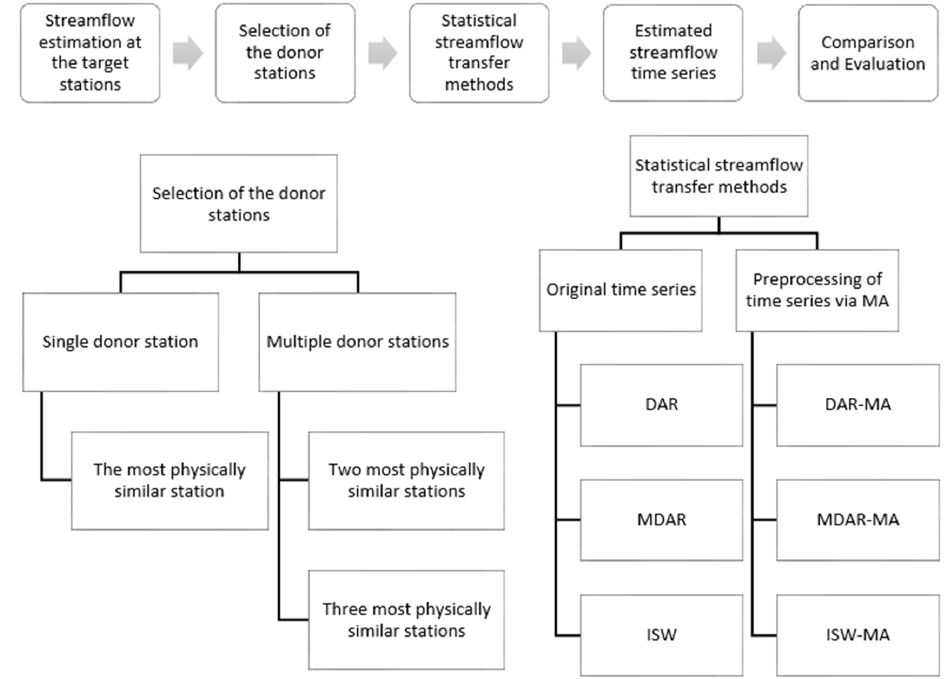
Figure 5. Proposed flowcharts for streamflow estimation at the target station.